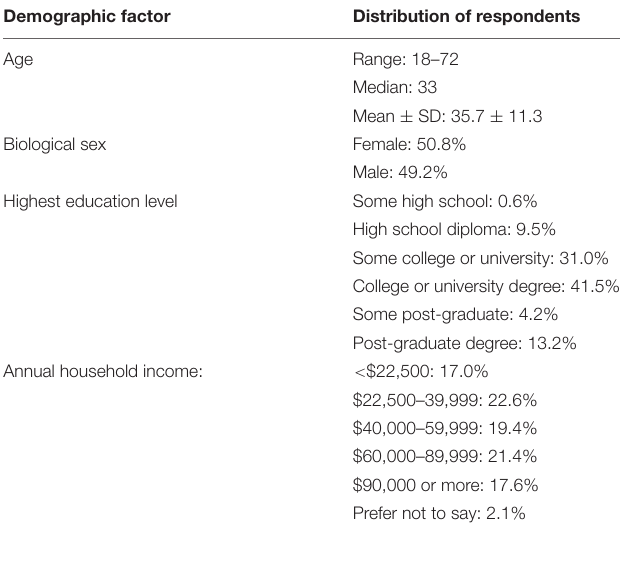
TABLE 1 | Demographic characteristics of